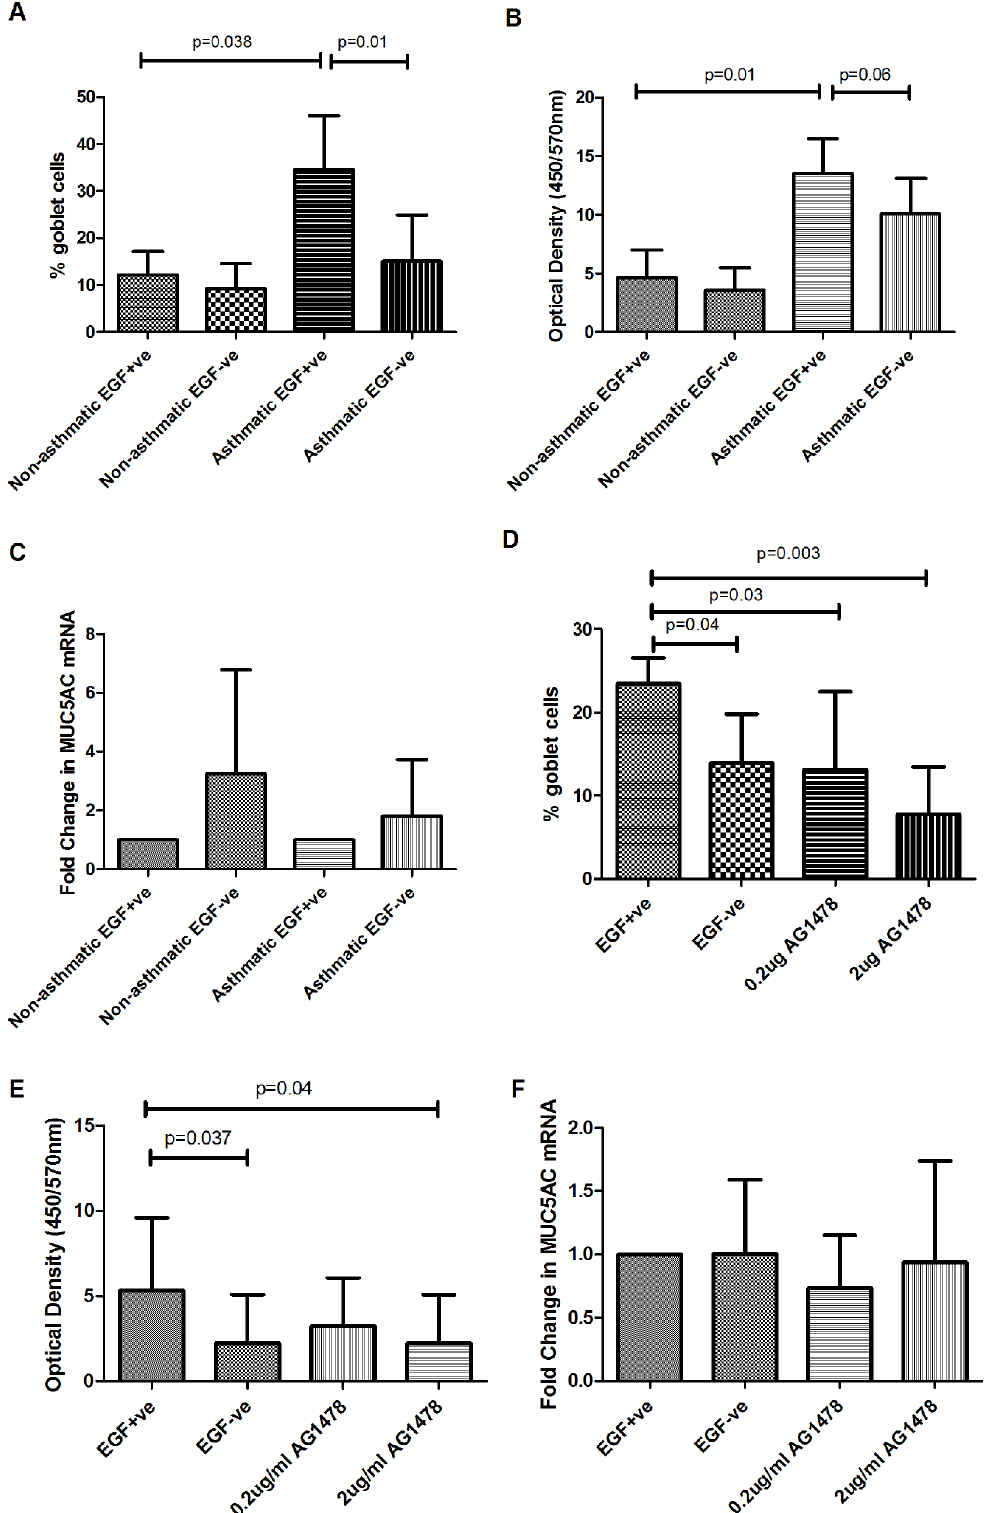
Fig 3. Goblet Cell Quantification, MUC5AC Secretion Measurements and MUC5AC qPCR. (A) Goblet cells expressed as a percentage of total in asthmatic and non-asthmatic cultures in the presence or absence of EGF (10ng/ml) (n = 5). Data analysed using a 2-way repeated measures ANOVA with